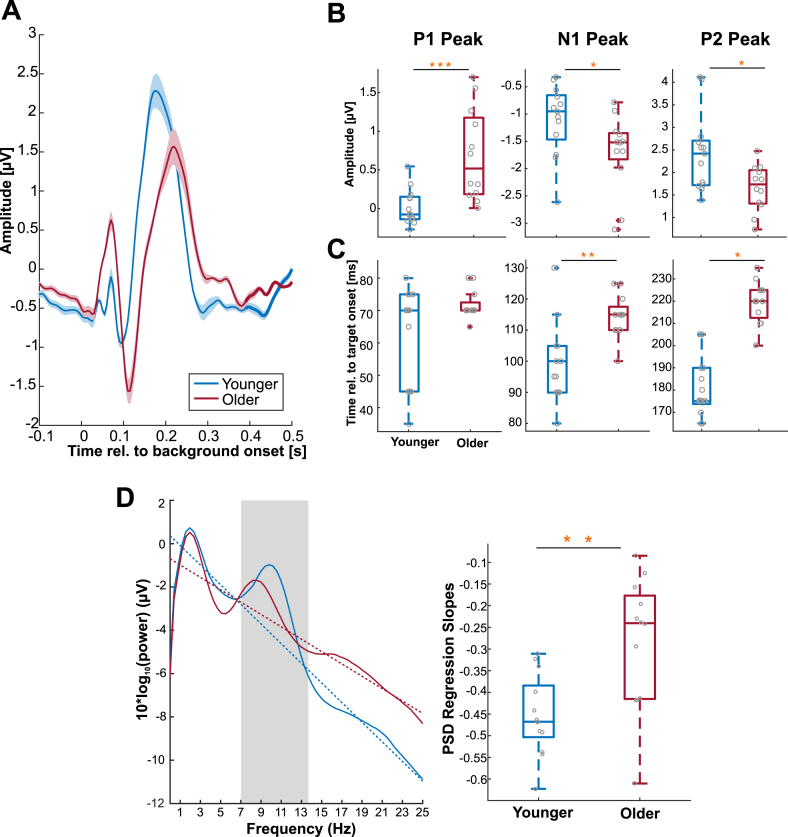
Auditory evoked responses to background onset and pre-stimulus power spectral density. (A) Grand-average AEPs with standard error (SEM) over central channels (FC1, FCz, FC2, C1, Cz, C2, CP1, CPz, CP2). Both younger and older subject display a clear P1-N1-P2 potential. (B) A comparison of AEP peak amplitudes between groups revealed an age-related enhancement of P1 and N1 peaks, and a reduction in the P2 peak. (C) Component peaks were also compared in terms of latencies, revealing an age-related delay in N1 and P2 peaks. (D left panel) Group-averaged PSD estimates (smooth curves) and fitted regression slopes (dashed lines) for frequencies up to 25 Hz, averaged over all channels. Slopes were computed whilst ignoring alpha power between 7 and 14 Hz (indicated by shaded area). (D right panel) PSD slopes were flatter for the older adults. Grey circles indicate individual subject data. Yellow asterisks indicate significance as follows: *p < 0.05, **p < 0.01, ***p < 0.001.